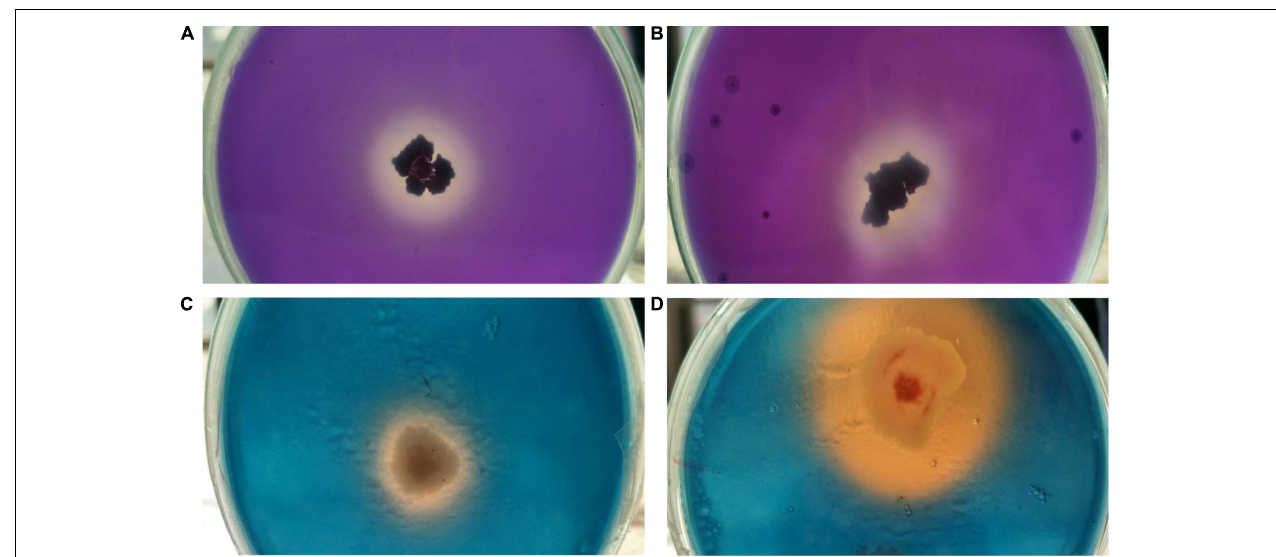
FIGURE 4 | Assessment of multiple plant growth promoting traits of endophytic strains OS_12 and OS_25. (A,B) Zone of phosphate solubilization on NBRIP medium amended with Tricalcium phosphate. (C,D) Production of siderophore on CAS agar